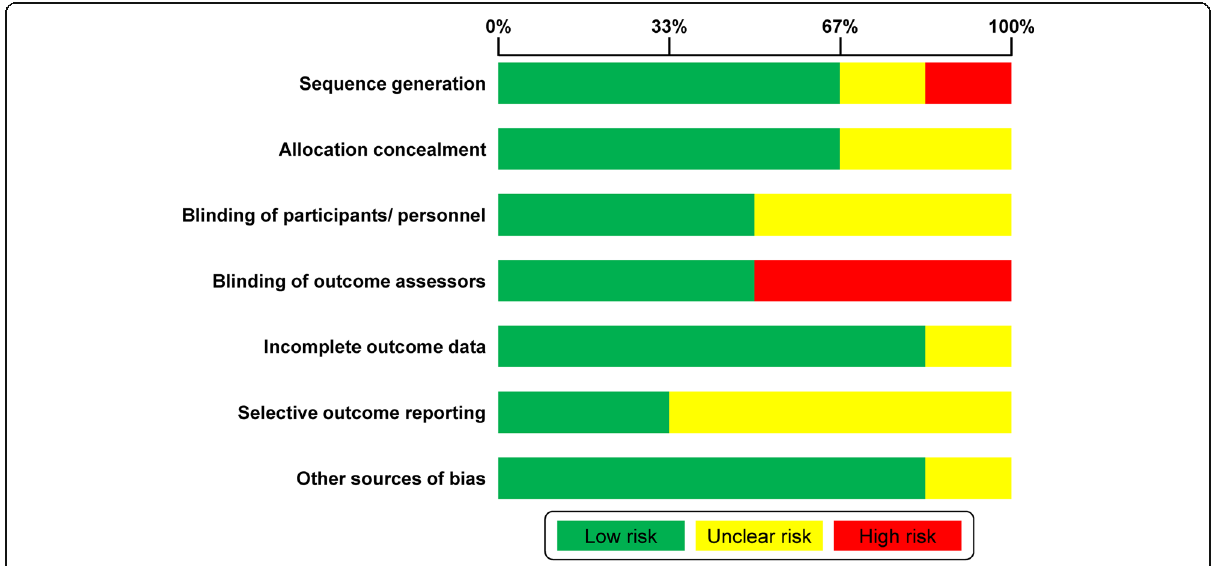
Fig. 2 Risk of bias summary for included randomized trials with the Cochrane tool